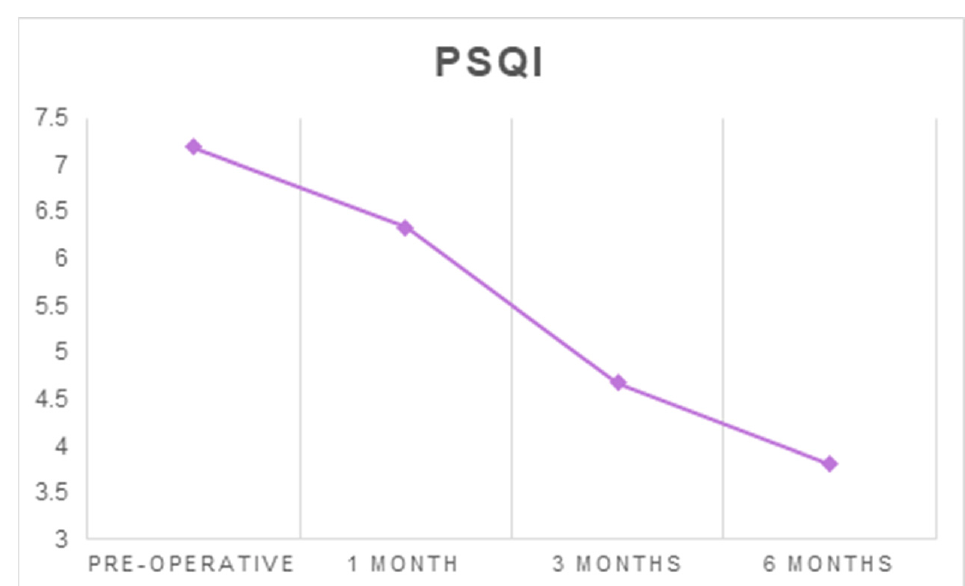
Figure 1. The average scores of the PSQI at each follow-up timepoint. The mean SF-36 score increased from 58.15 ± 17.35 before surgery to 78.75 ± 14.9 at six months after surgery ( p < 0.001) (Tables 1 and 2, Figure 2).